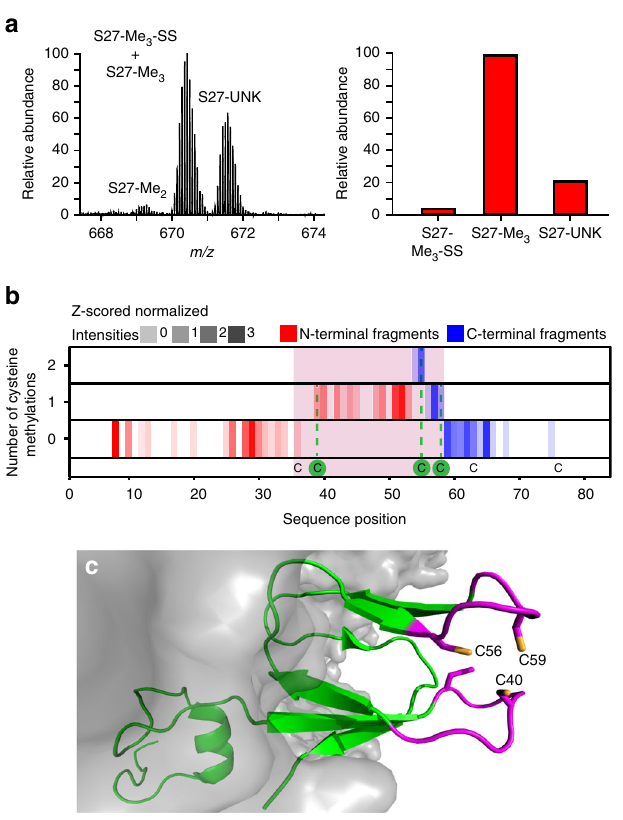
Fig. 5 Characterization of ribosomal stalk complexes; composition, post- translational modi fi cation and stoichiometry. a Sequence alignment of the fl exible tail region of the ribosomal protein L10 from two thermophiles ( T. maritima and T. thermophilus ) and two prokaryotes ( B. subtilis and E. coli ) with chloroplastic L10 from S. oleracea . The presence of three L7/L12 dimer binding sites predicts chloroplast ribosomal stalks to have a heptameric stoichiometry (L10 [L7/L12] 6 ). b Determination of the chloroplastic ribosome stalk stoichiometry using a pseudo-MS3 experiment.